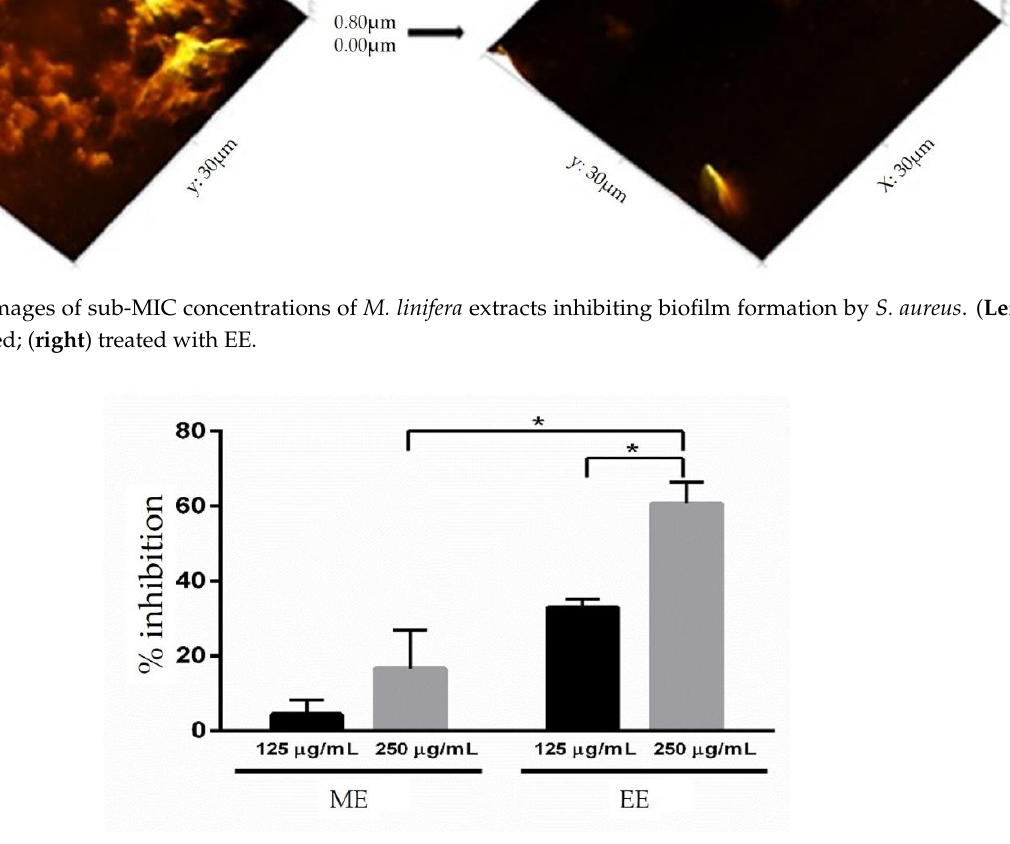
Figure 4. Average biofilm inhibition by ME and EE at 125 µg/mL and 250 µg/mL concentrations against S. aureus strain. The untreated biofilm (control group) represents 0% inhibition. *p<0.05. With the AFM results obtained, it was possible to calculate the average biofilm inhi- bition by ME and EE at different concentrations (Figure 4).